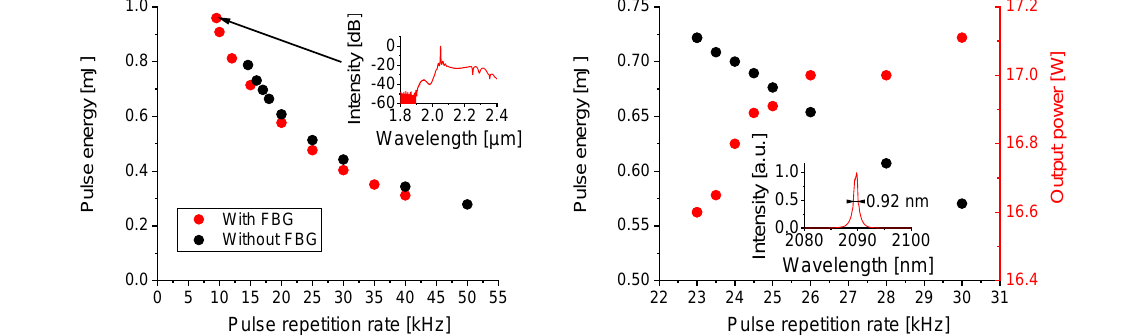
Figure 2: Pulse energy and average output power versus PRR at an operating wavelength of 2090 nm. The inset shows the output spectrum at the highest pulse energy of 720